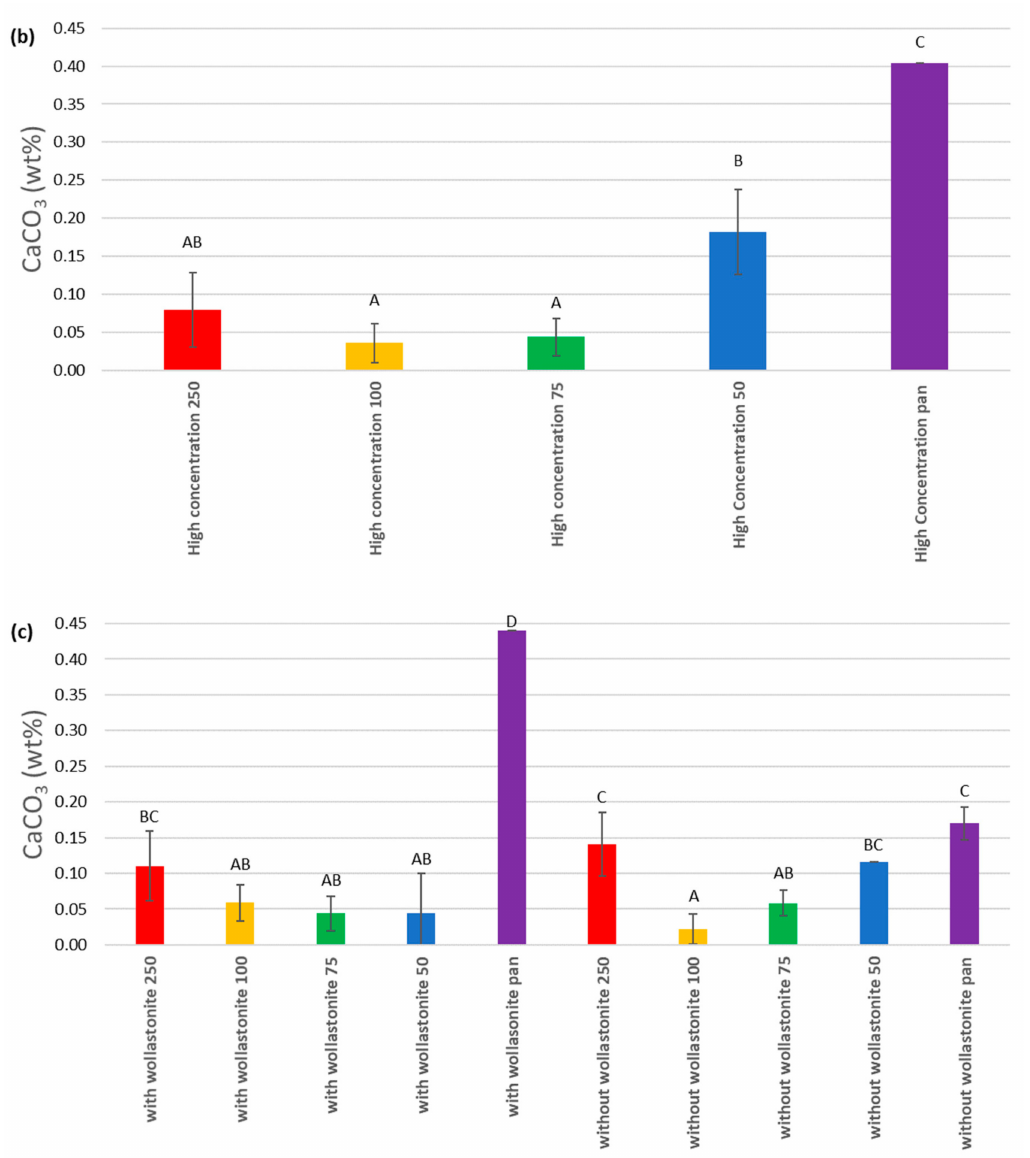
Figure 1. Calcimeter analysis of the soil fractions fractionated from the soils sampled at three di ff erent sites: ( a ) rooftop “control” and amended plots (“RFT”), ( b ) soybean farm (“high concentration”), and ( c ) potato farm (“with” and “without” wollastonite). Color coding relates to sieve sizes, error bars represent the standard deviation of triplicate samples, and lettering relates to Tukey’s HSD test groups. From Figure 1b, for the soil sampled from the soybean field, denoted as “high concentration” − 1 because of the wollastonite field application rate of 4.942 tonne · ha used (the highest used in that farm), it can be seen that the amount of CaCO 3 in the 250- µ m to 50- µ m sieve agricultural soil fractions is much lower (0.04–0.18 wt.% CaCO 3 , or 0.18–0.79 g CO 2 / kg soil) compared to the fraction from the pan (0.40 wt.% CaCO 3 , or 1.76 g CO 2 / kg soil). Like with the rooftop soils, the pan fraction from the soybean farm soil is found to be statistically di ff erent than the other fractions of the same soil, according to Tukey’s HSD test groups. For the soils sampled from the potato field (Figure 1c), the pan fraction of the wollastonite-amended soil (denoted as “with wollastonite pan”) contained higher CaCO 3 as compared to the pan fraction of the control soil (“without wollastonite pan”), which suggests that carbonate formed as a result of wollastonite weathering and / or carbonation. Tukey’s HSD test confirms that the amended pan fraction belongs to a di ff erent group than all other